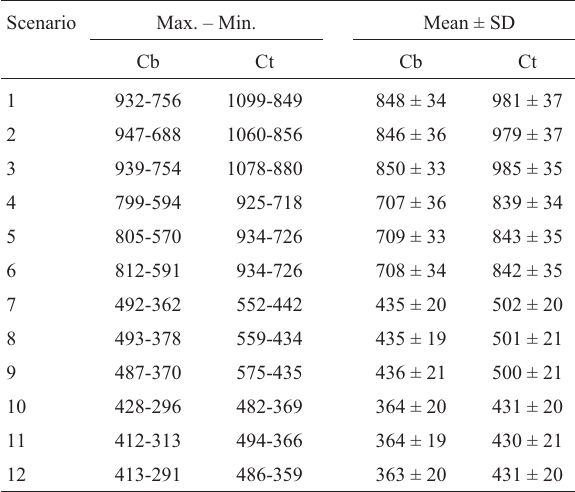
Table 3 - Time to extinction for the maned wolf (Cb) and the crab-eating fox (Ct) in 12 simulation scenarios (see Table 1). Scenario Max. – Min.